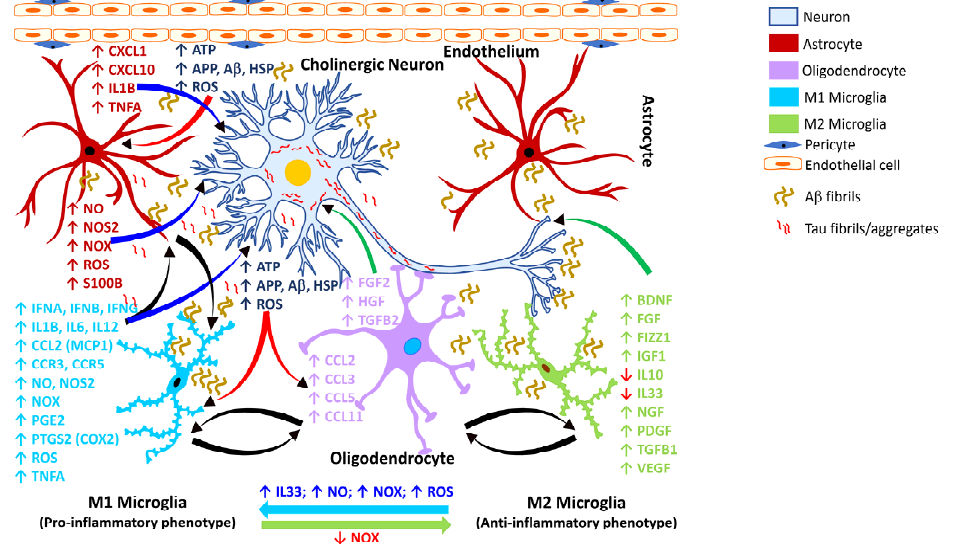
Figure 2. Inflammatory cascade in Alzheimer’s disease. Schematic representation of the molecular mechanisms associated with glia ‐ mediated functional interactions and systematic perturbations within the CNS to induce neuroinflammation in Alzheimer’s disease. The endothelial cells form the inner lining of the blood vessel with pericytes enveloping the surface of the vasculature forming tight junctions to maintain the BBB integrity. Upon insult, the augmented production and release, as well as impaired clearance of A β and Tau fibrils sustains chronic activation of the primed microglia resulting in the production and release of proinflammatory mediators including free radicals, cytokines and chemokines, thereby affecting the resident CNS cells (astrocytes, oligodendrocytes, and neurons) and leading to A β and Tau aggregation. M1 microglia (proinflammatory phenotype, neurotoxic) release various proinflammatory mediators including free radicals, cytokines, and chemokines that further stimulate other glial cells and collectively contribute to exacerbating the neuronal injury/damage. M2 microglial cells (anti ‐ inflammatory phenotype, neuroprotective) can polarize to an M1 state and release proinflammatory mediators in the presence of increased levels of NOX, ROS, NO, and IL33 released by M1 microglia and/or astrocytes and thereby augment the neuroinflammatory and neuronal injury process leading to synaptic dysfunction, neuronal injury, and neuronal death. Astrocytes respond by releasing proinflammatory mediators including free radicals, cytokines, and chemokines, which further contribute to enhancing the endothelial perme ‐ ability, disrupting BBB integrity, and allowing for infiltration of peripheral immune cells, events that further intensify inflammation and neuronal injury. Feedback regulation of NOX or its inhibi ‐ tion causes M1 microglia to polarize to the M2 state (anti ‐ inflammatory phenotype), which down ‐ regulates M1 functions and promotes regulation of neuroinflammation and neurorepair by releas ‐ ing anti ‐ inflammatory mediators such as cytokines, neurotrophic, and growth factors. Mediators released by specific neural cell types (neuron, astrocyte, microglia, or oligodendrocyte) are listed adjacent to each cell type in similar colored text. Curved arrows indicate the direction of signal flow between various neural cells for the inflammation activation process. Red curved arrows show the directional flow of danger/damage signals from neurons to glial cells (astroglia, microglia, oligoden ‐ droglia); blue curved arrows show the flow of proinflammatory signals from astrocytes and M1 microglia towards distressed neurons; green curved arrows show the flow of neurotrophic signals from M2 microglia and oligodendroglia towards the distressed neurons as a neuroprotective/neu ‐ rorescue endeavor; black curved arrows show the directional crosstalk among various glial cells to mount a glial response to neuronal injury/damage. ↑ , increase; ↓ , decrease; A β , beta amyloid; APP, amyloid precursor protein; ATP, adenosine triphosphate; BBB, blood ‐ brain barrier; BDNF, brain ‐ derived neurotrophic factor; CCL2, C ‐ C motif chemokine ligand 2 (also referred to as MCP1, mon ‐ ocyte chemoattractant protein 1); CCL3, C ‐ C motif chemokine ligand 3; CCL5, C ‐ C motif chemokine ligand 5; CCL11, C ‐ C motif chemokine ligand 11; CCR3, C ‐ C motif chemokine receptor 3; CCR5, C ‐ C motif chemokine receptor 5; 1; CXCL1, C ‐ X ‐ C motif chemokine ligand 1; CXCL10, C ‐ X ‐ C motif chemokine ligand 10; FGF, fibroblast growth factor; FGF2, fibroblast growth factor 2; FIZZ1, found